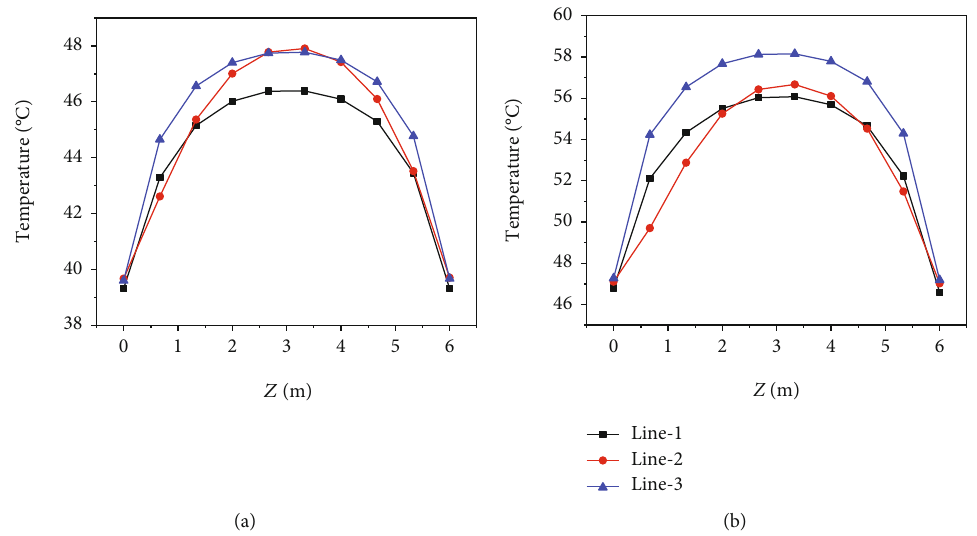
Figure 8: Temperature variation inside the greenhouse dryer according to lines 1 to 3 for (a) day-1 and (b)